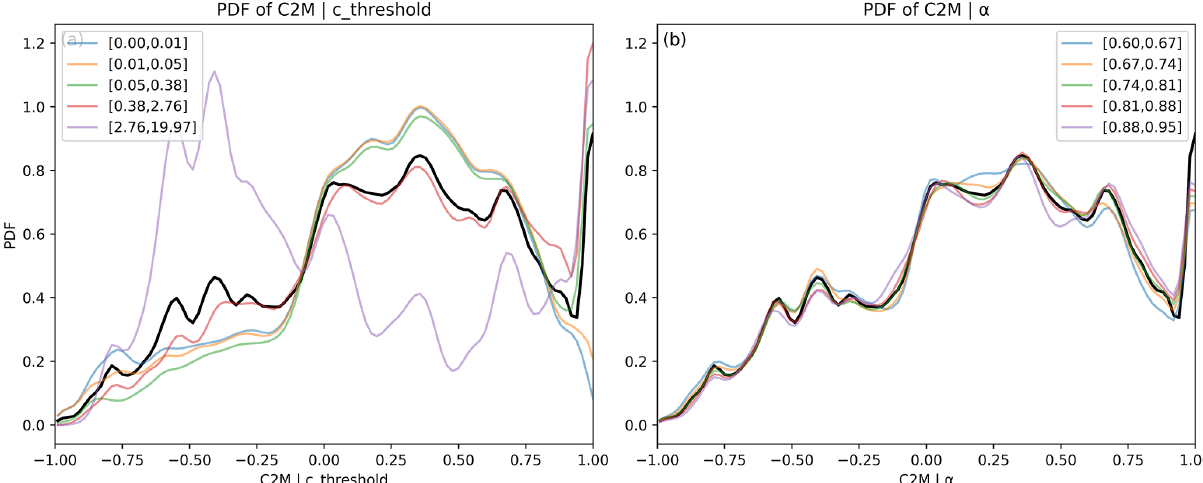
Figure 12. Shifts in C 2M ’ probability distribution function (PDF) depending on c threshold (a) and α (b) range values, within irrigation reservoirs. The unconditional PDFs of the DROP model output C 2M , obtained when all input parameters are randomly sampled, are displayed in black. The conditional PDFs are shown in color depending on the parameter value